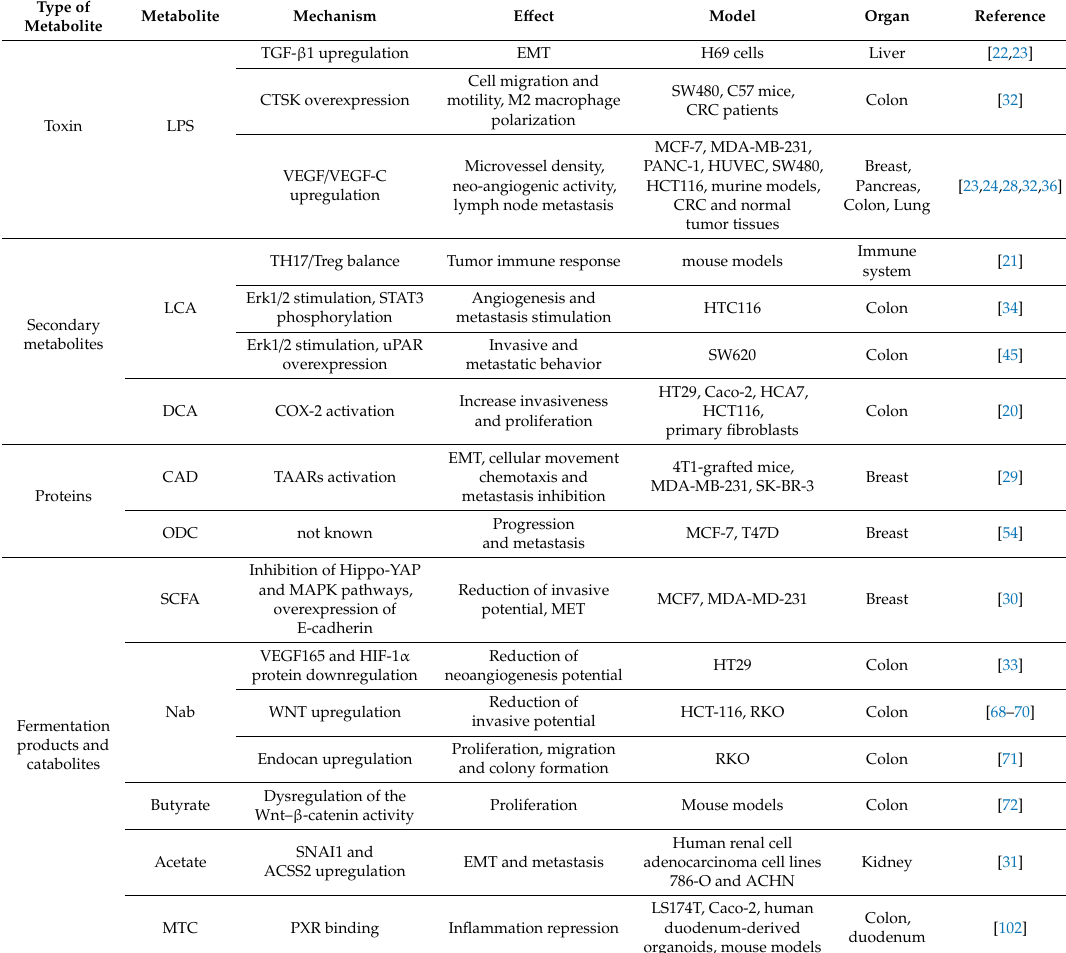
Table 1. Metabolites involved in metastasis onset and their e ff